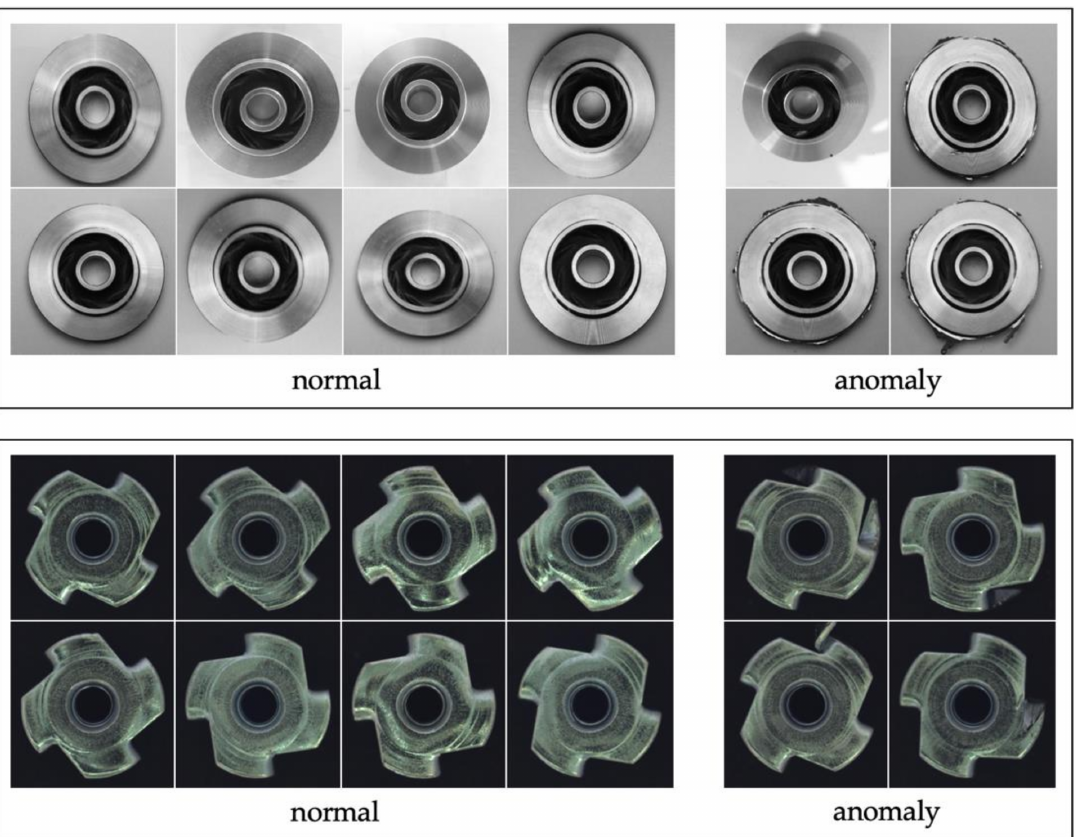
Figure 5. Sample images from MC dataset ( first row ) and MVTec Metal-nut dataset ( second row